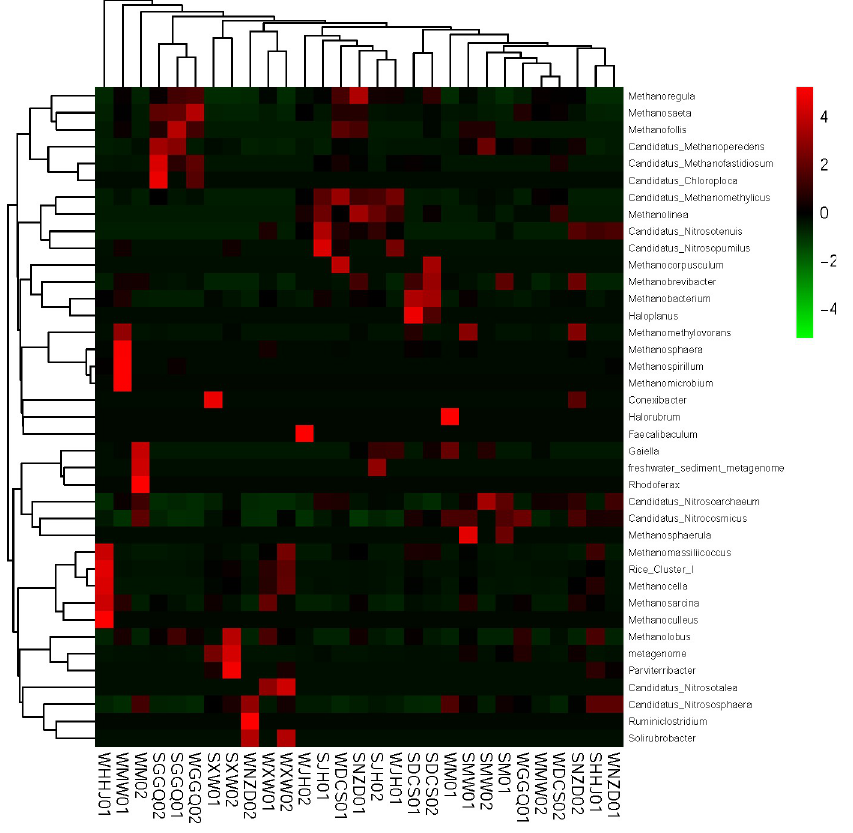
Fig 5. Relative abundance of the major archaeal genera from LRCR.